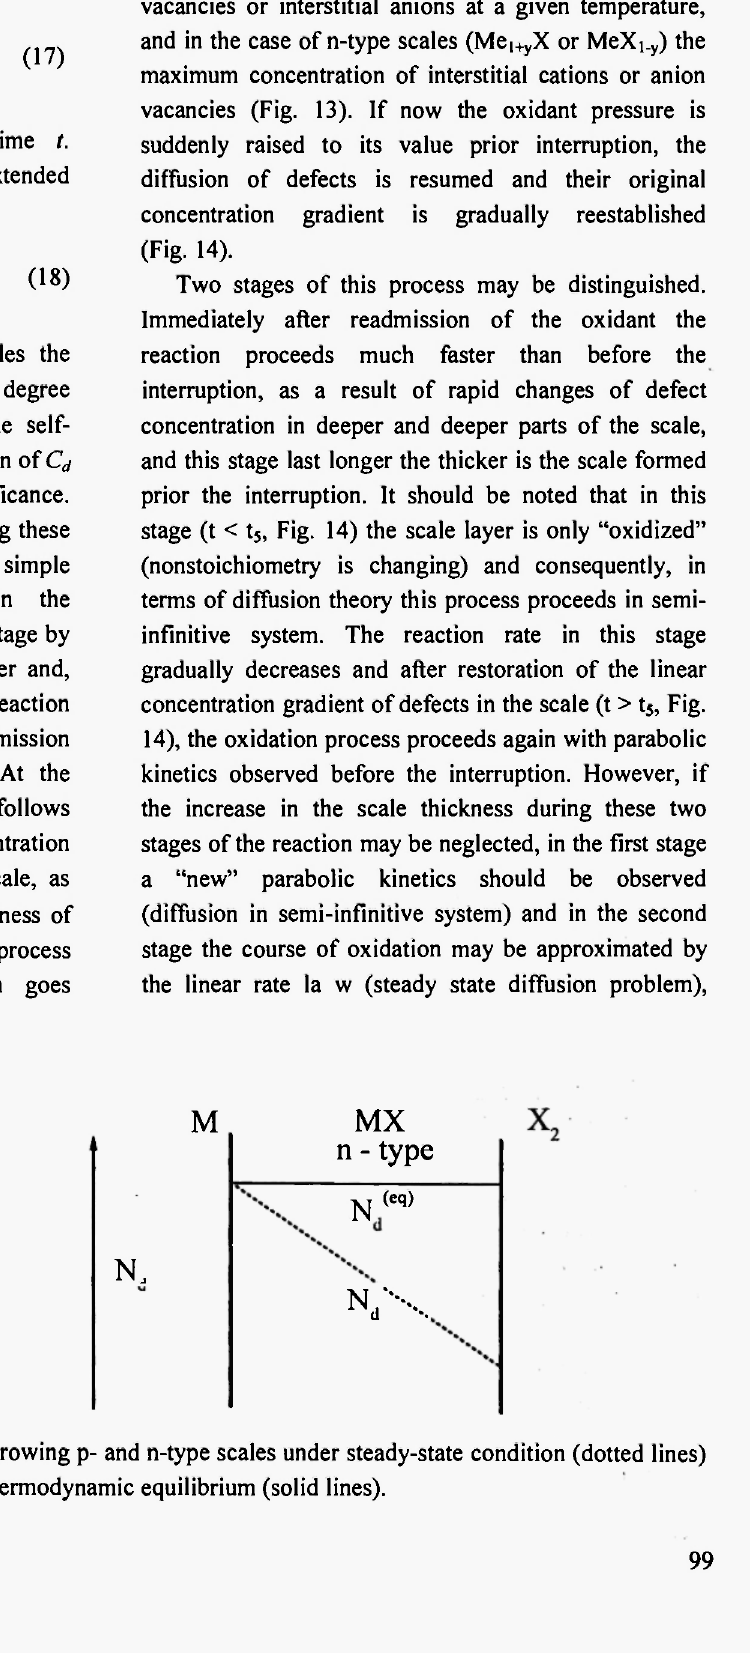
Fig. 13: Defect distribution (schematic) in the growing p- and η-type scales under steady-state condition (dotted lines) and in the Me-MeX-X 2 system at the thermodynamic equilibrium (solid